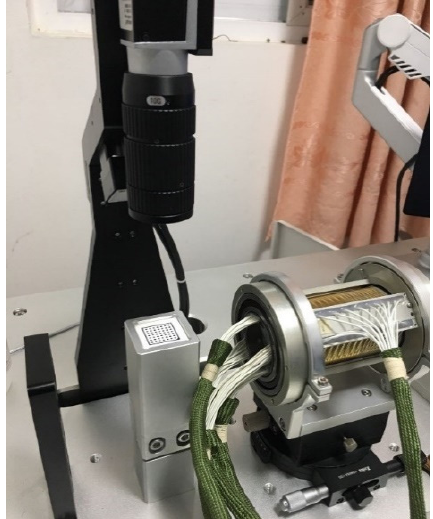
Figure 12. Calibration of optical imaging system.